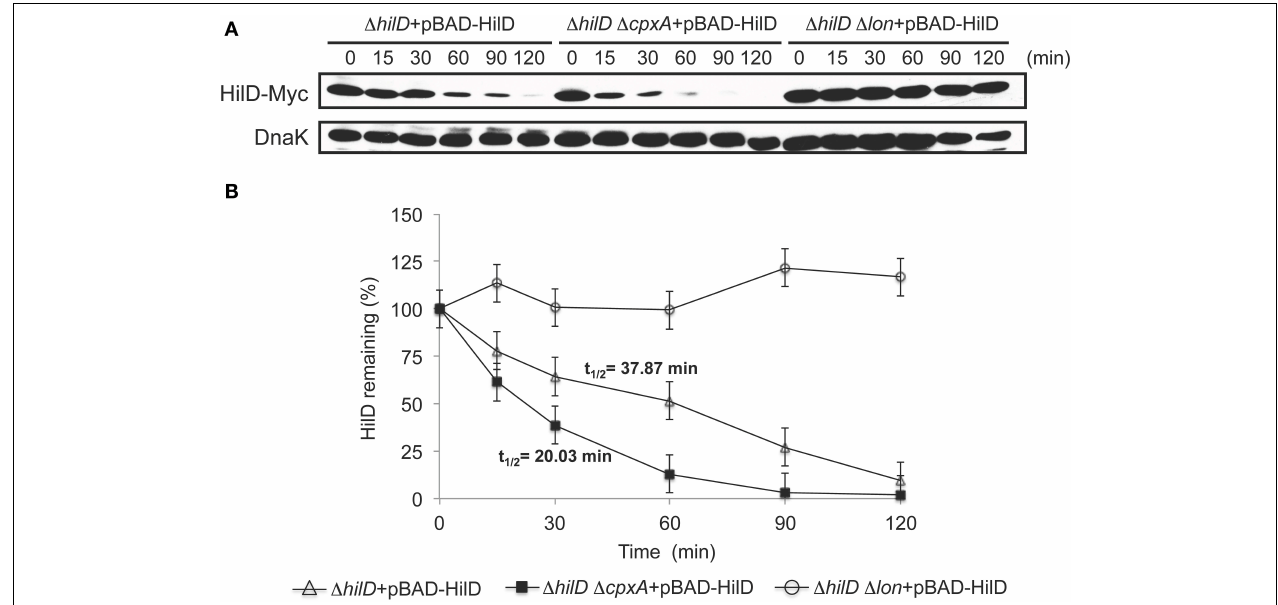
antibodies. As a loading control, the expression of DnaK was also determined using monoclonal anti-DnaK antibodies. A representative Western blot of three independent experiments is shown. (B) Densitometric analysis of the HilD-Myc bands from the Western blots is indicated as the relative percentage of HilD-Myc at each time with respect to time 0. Intensity values of HilD-Myc bands were normalized with those respective of DnaK bands. The data are the averages of three independent experiments. Bars represent the standard deviations and t 1 / 2 indicates the half-life of